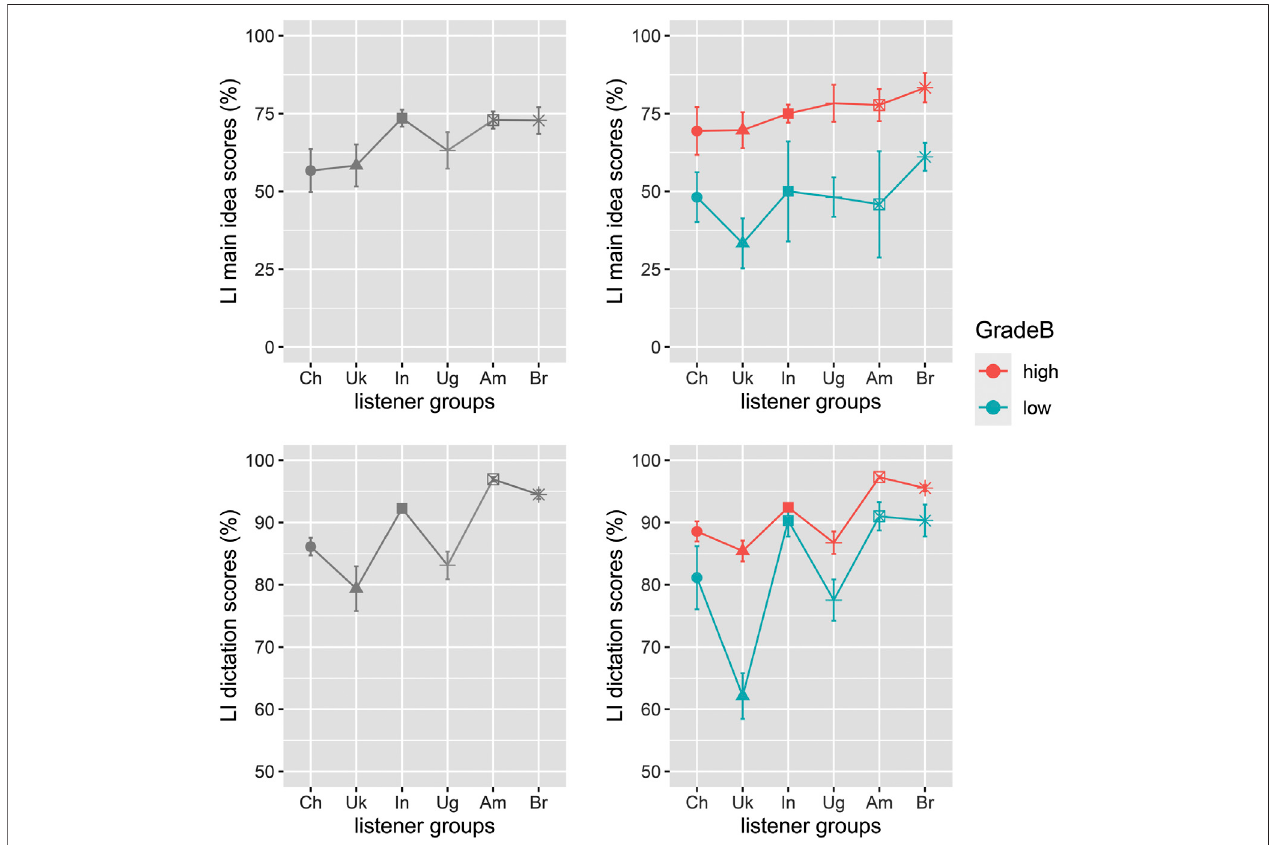
FIGURE1| Listenerintelligibilitygroups (left) andgroups*Englishgrades (right) plotsusing20%trimmedmeansandstandarderrors:Note.Subjectnumbersare: Ch (cid:1) 23 (high (cid:1) 10 and low (cid:1) 13), Uk (cid:1) 26 (high (cid:1) 17 and low (cid:1) 9), In (cid:1) 27 (high (cid:1) 24 and low (cid:1) 3), Ug (cid:1) 29 (high (cid:1) 14 and low (cid:1) 15), Am (cid:1) 26 (high (cid:1) 20 and low (cid:1) 6), Br (cid:1) 29 (high (cid:1) 19 and low (cid:1)